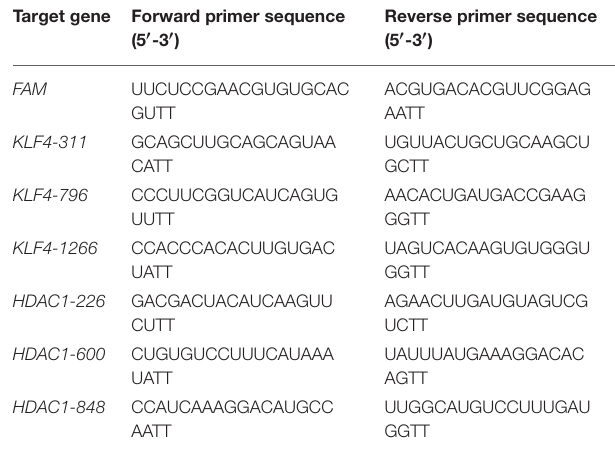
TABLE 2 | Primer sequences of